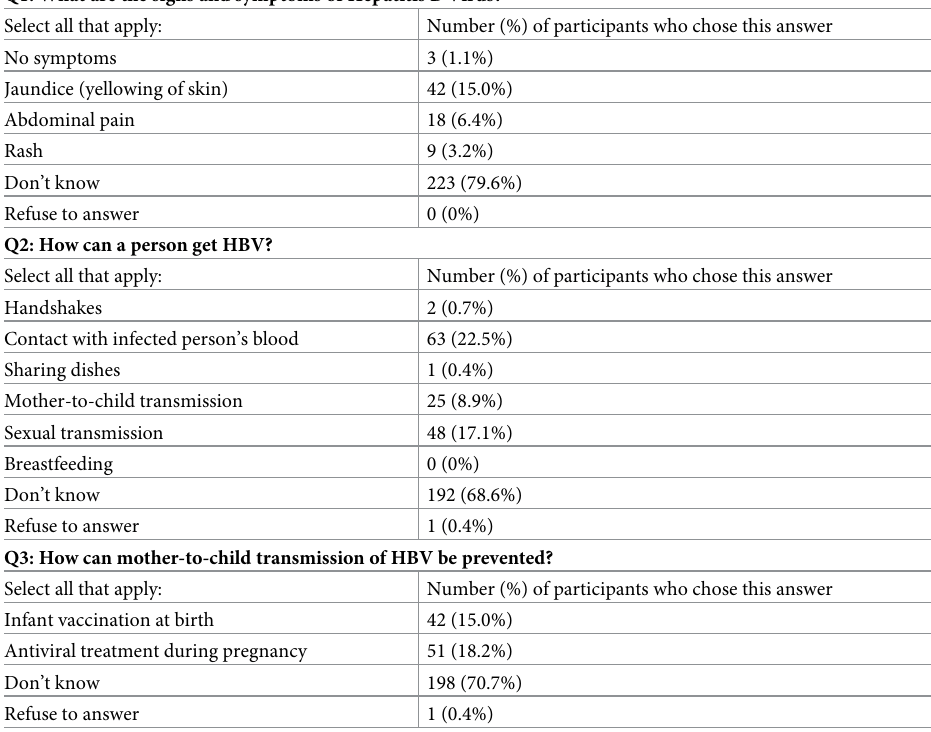
Table 2. Distribution of responses to the three questions assessing Hepatitis B knowledge among all enrolled women. 280 total participants responded to each question. Because participants could choose multiple answers to each question, percent of participants who chose each answer sums to greater than 100% for each question. The percent of participants who chose each answer was calculated using total number of participants as the denominator, not total number of answers chosen.